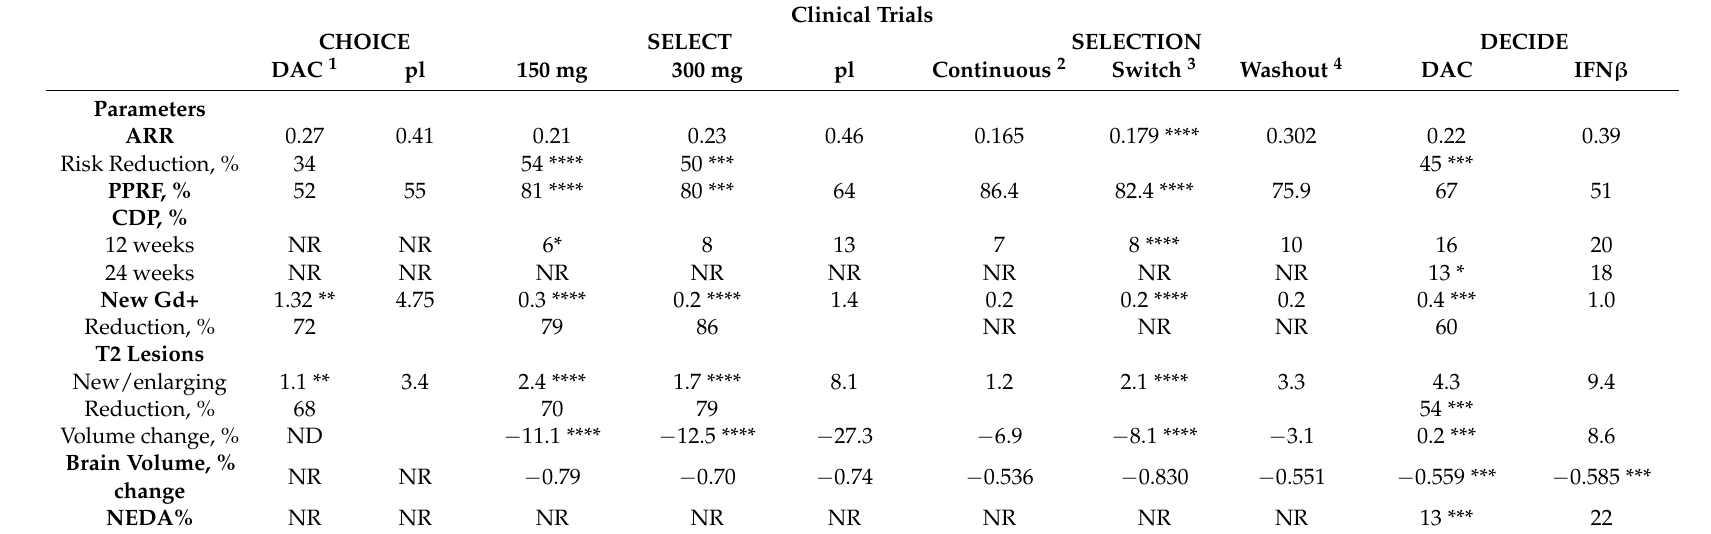
Table 1. Selected Clinical and MRI Outcomes of DAC HYP Treatment in RMS Controlled